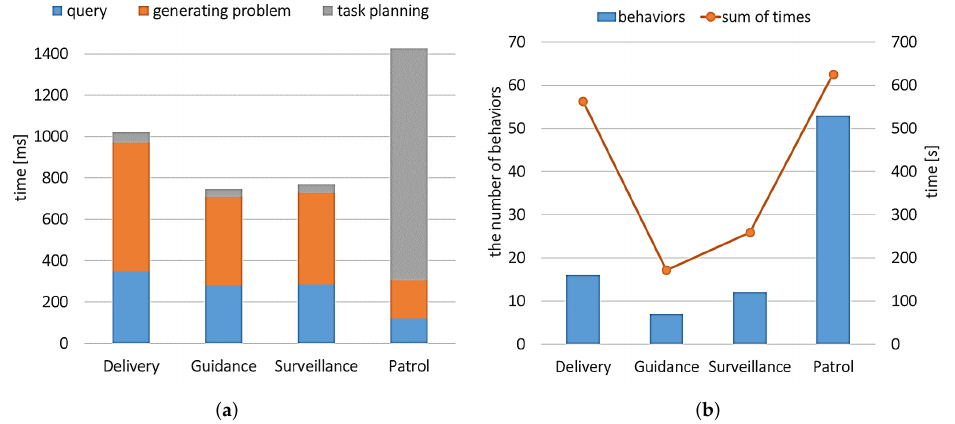
Figure 9. Comparison of four scenarios: delivery, guidance, surveillance, and patrol. ( a ) Query time for the on-demand database (blue), generating the problem file time (orange), and task planning time (gray). ( b ) The number of behaviors (blue) and the sum of times for the sequence